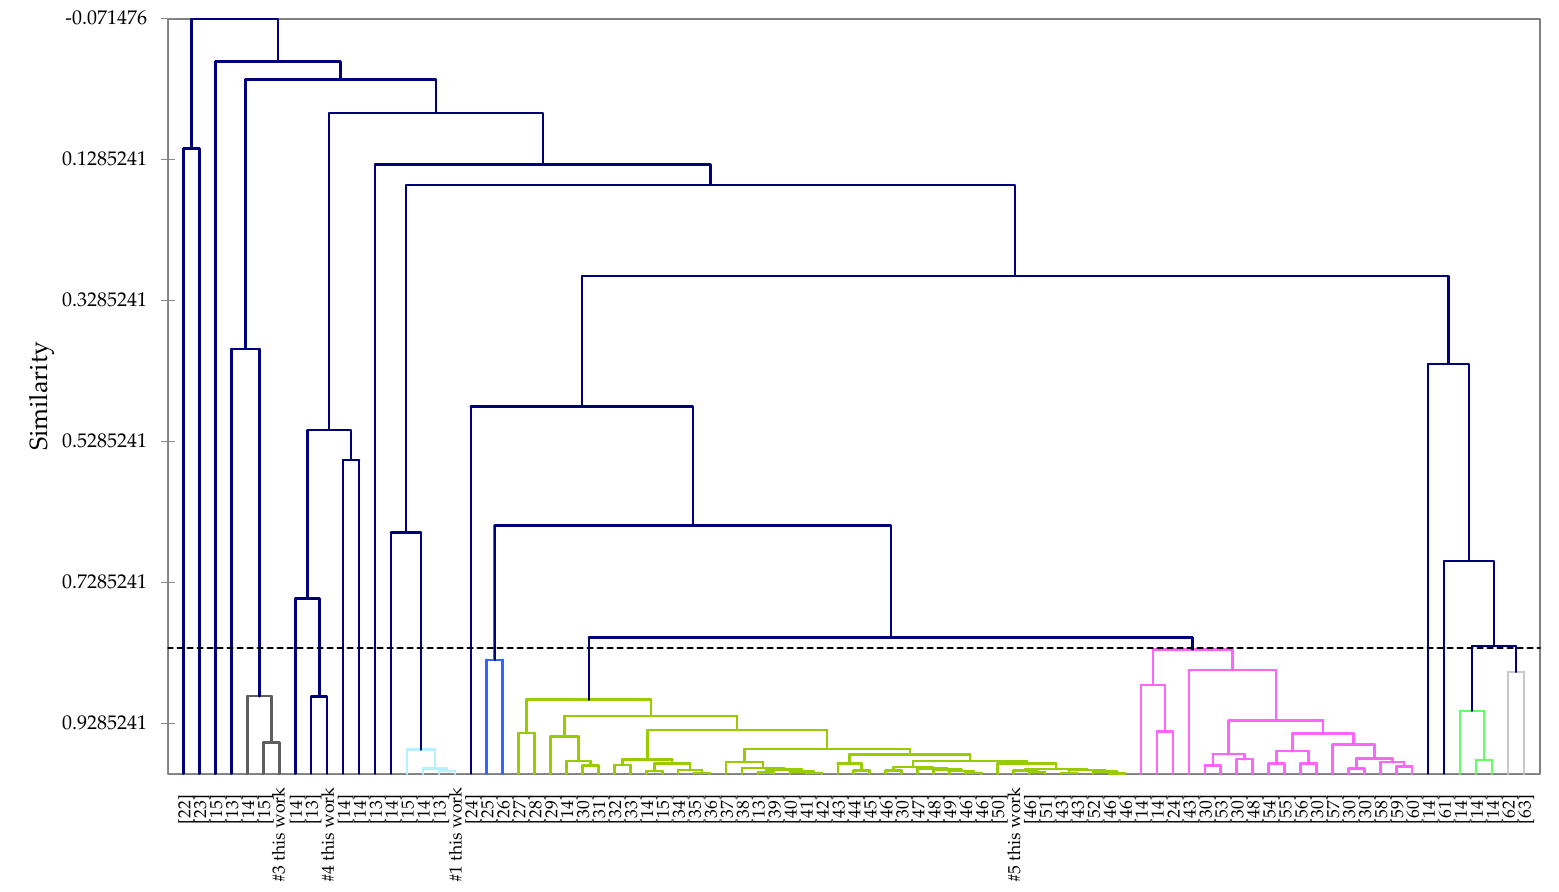
Figure 1. Dendrogram obtained from the agglomerative hierarchical cluster analysis of 85 Thymus vulgaris essential oil compositions.